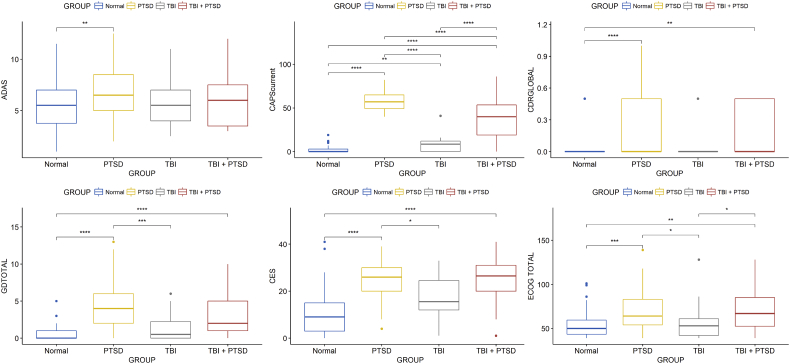
Charts showing the Neurophysiological and clinical outcomes differences. Significant differences were identified with p < 0.01. CAPS, Clinician-Administered PTSD Scale; CES, Center for Epidemiologic Studies Depression Scale; CDR, Clinical Dementia Rating; ECOGtotal, total score for Everyday cognition; GDtotal, Geriatric Depression Scale; FSIQ, Full Scale Intelligence Quotient; TBI, traumatic brain injury; PTSD, post-traumatic stress disorder; TBI_PTSD, TBI subjects who developed PTSD.